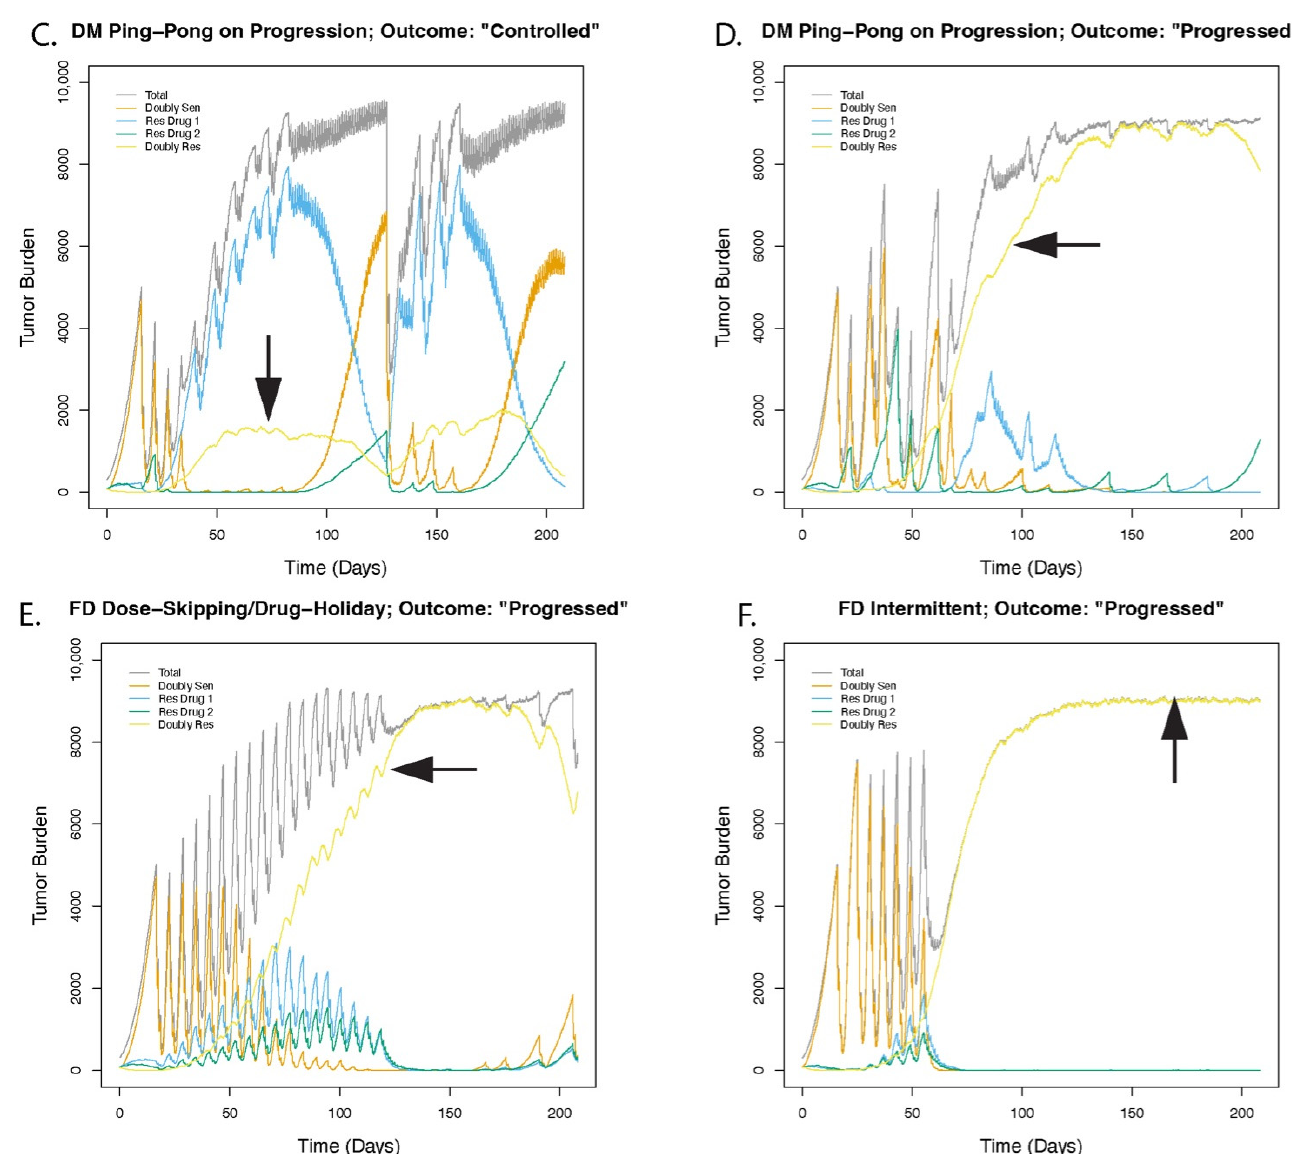
Figure 4. Two-drug therapies, comparing standard of care standard treatment (ST) versus variations of dose modulation (DM) and fixed dose (FD) adaptive therapy. Tumor burden was measured every 3 days. ST applied the maximum tolerated dose at each measurement. ( A ) Survival curves for DM adaptive therapy protocols (DM Cocktail Tandem, DM Ping-Pong Alternate Every Cycle, and DM Ping-Pong on Progression) and FD adaptive therapy protocols (FD Dose-Skipping/Drug Holiday and FD Intermittent) compared with ST. The dose modulation protocols uniformly worked better than the other protocols. ( B ) Cell population dynamics for a tumor treated with the ST protocol (continuous MTD). Therapy started at about day 20 when the tumor reached 5000 cells. The results clearly show the effects of competitive release, leading to rapid progression. ( C ) Cell population dynamics for a tumor treated with the DM Ping-Pong on Progression protocol, controlling the doubly resistant cells. There was a dip in tumor burden at about 125 days owing to switching from a low dose of drug 1 to a high dose of drug 2. ( D ) Cell population dynamics for a tumor treated with the DM Ping-Pong on Progression protocol resulting in the less frequent outcome of progression. At around day 70, therapy killed almost all the sensitive and singly resistant cells, leaving insufficient cells to keep the doubly resistant cells in check. ( E ) Cell population dynamics for a tumor treated with FD Dose-Skipping/Drug Holiday resulting in rapid progression. ( F ) Cell population dynamics for a tumor treated with the FD Intermittent protocol resulting in progression. Populations of